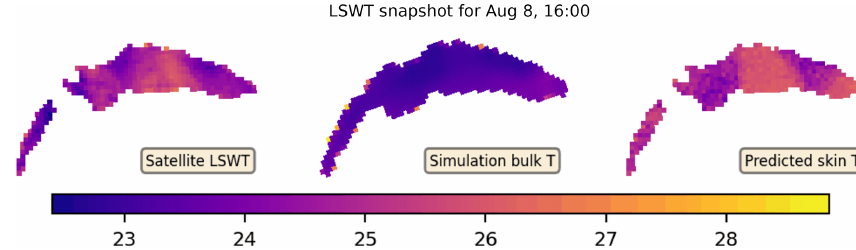
Figure 11. A comparison of LSWT snapshot from 8 August 2019 to the DA bulk and BiLSTM skin temperature predictions.